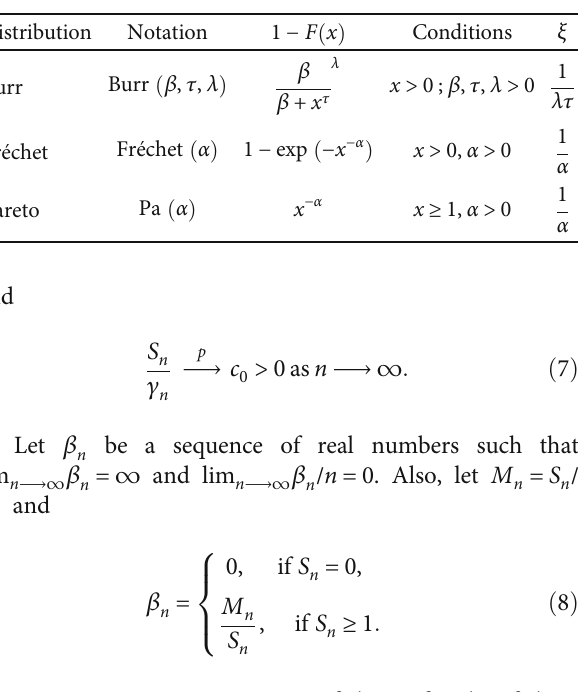
Table 1: Frechet-Pareto type